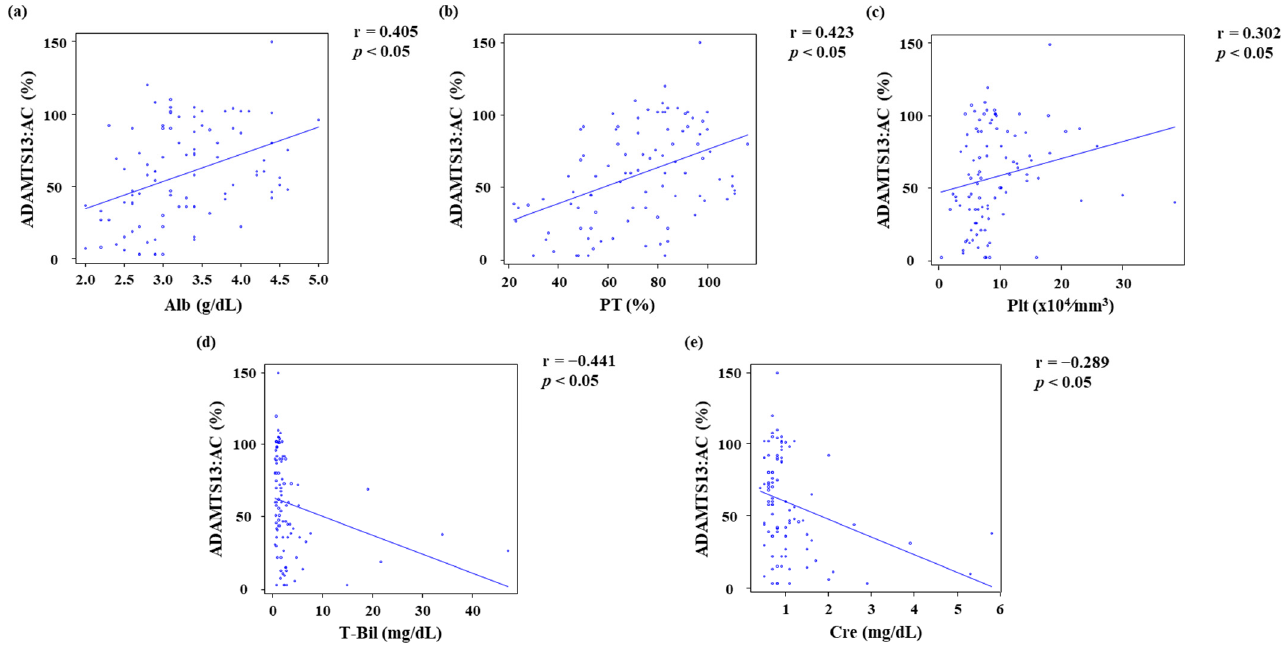
Figure 2. Relationship between ADAMTS13:AC and participant characteristics. ( a – c ) ADAMTS13:AC directly correlated with Alb (r = 0.405, p < 0.05), PT (r = 0.423, p < 0.05), and Plt (r = 0.302, p < 0.05). ( d , e ) ADAMTS13:AC inversely correlated with T-Bil (r = − 0.441, p < 0.05) and Cre (r = − 0.289, p < 0.05). ADAMTS13, a disintegrin-like and metalloproteinase with thrombospondin type 1 motifs 13. ADAMTS13:AC, ADAMTS13 activity; Alb, albumin; PT, prothrombin time; Plt, platelet count; T-Bil, total bilirubin; Cre, creatinine.